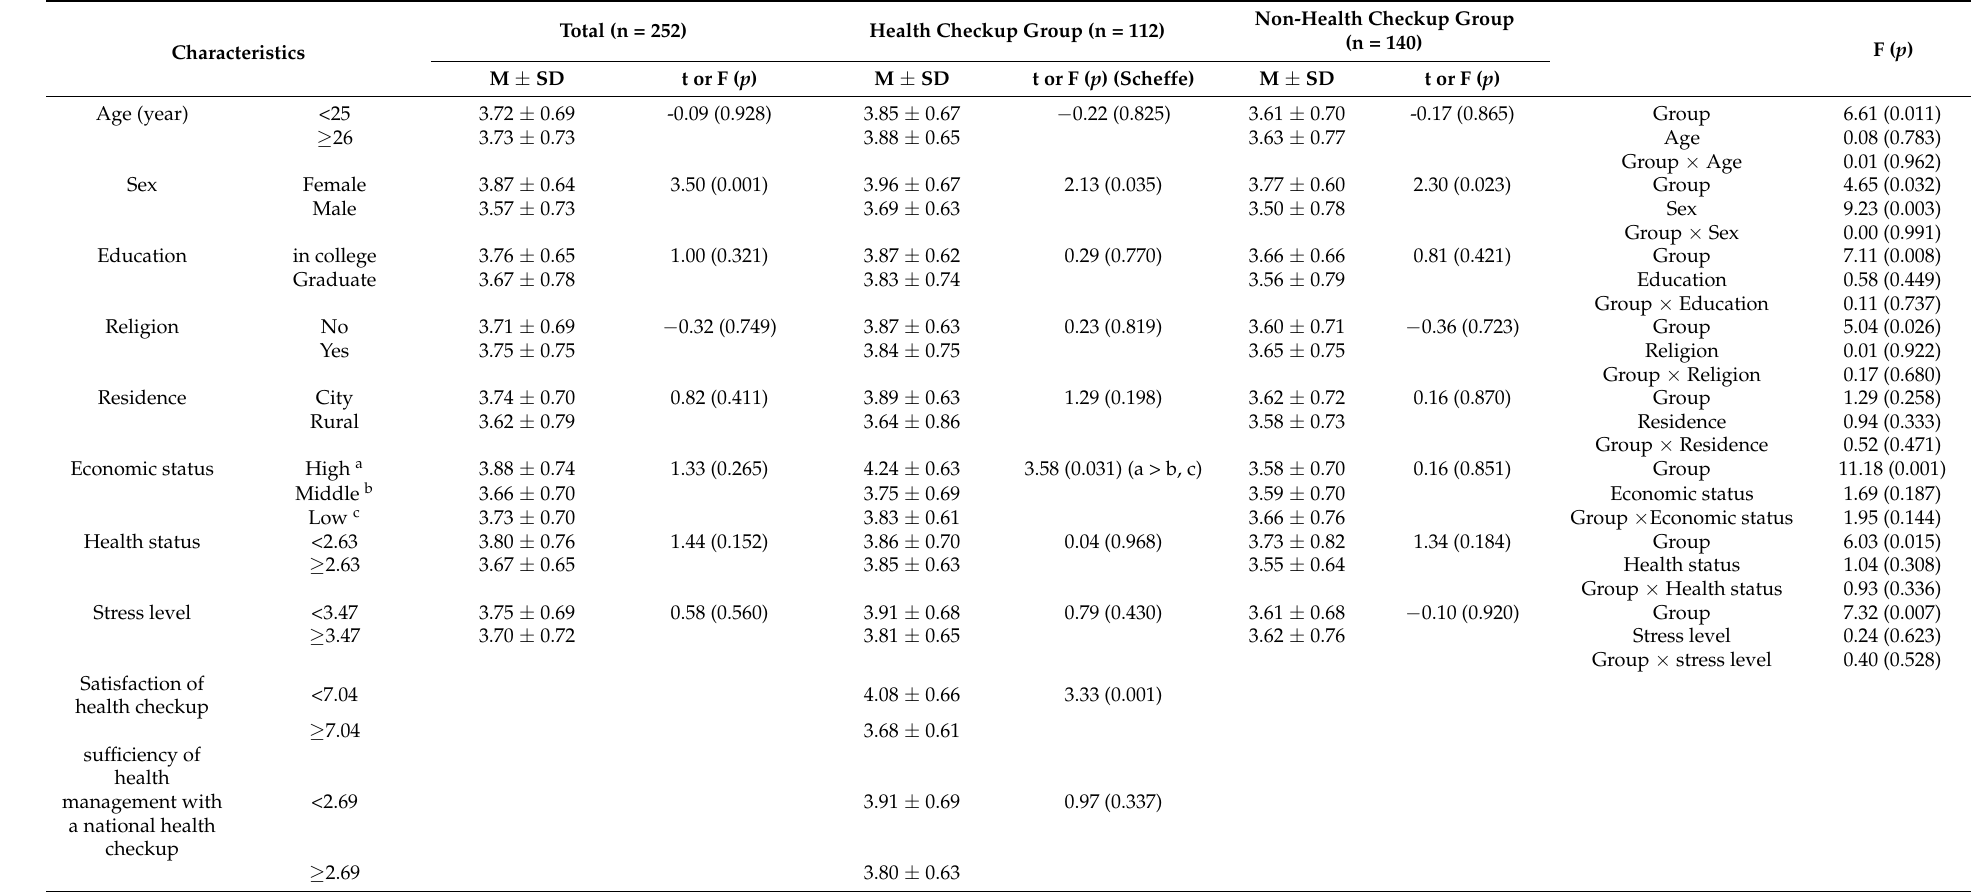
Table 3. Differences in intentions to health checkups according to participants’